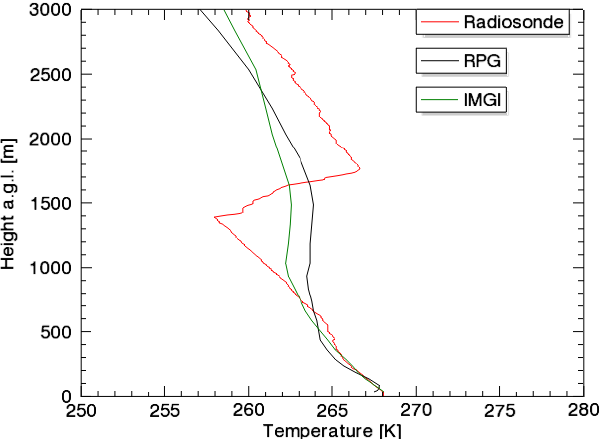
Figure 7. Humidity vertical profile within the full troposphere. The comparison is between (differently colored lines, see inlet) ra- diosonde, RPG algorithm, IMGI algorithm. They refer to 3 Septem- ber 2012 at 02:02UTC (launch time of the radiosonde). The height is expressed in meters above